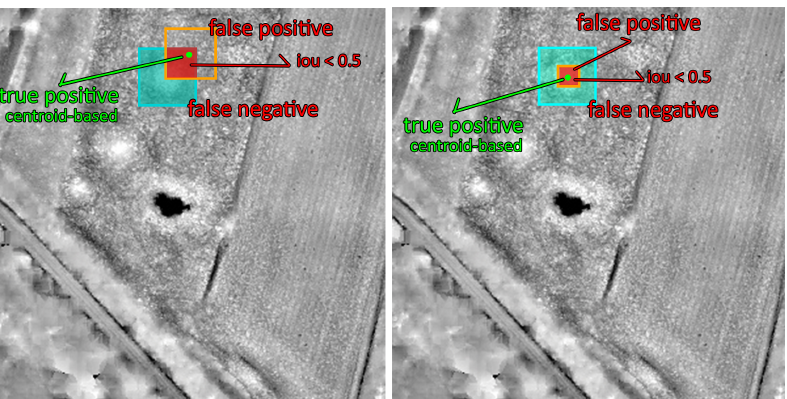
Figure 6. The IoU is not the ideal measure for the evaluation of discrete archaeological object methods since it does not consider the geographical position of the predicted bounding box in relation to the shapes or areas counting archaeological objects. ( Left ) The centroid-based measure considers, in line with the archaeologists’ thinking process, the prediction as a TP ( (cid:110) ) since the centroid of the predicted ( (cid:110) ) bounding box falls inside the ground truth’s bounding box ( (cid:110) ). On the other hand, the IoU considers the prediction as an FP ( (cid:110) ) because the intersection between the two bounding boxes is less than 0.5 times their union (see e.g., PASCAL VOC [15]). ( Right ) another example where the centroid-based is able to correctly consider a prediction as a TP, while the IoU considers it as an FP (see Section